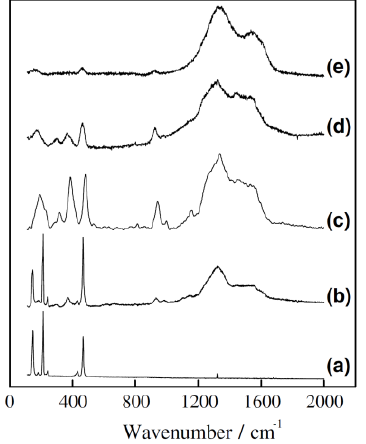
Figure 1. Raman spectra for (a) sulfur, and sulfurized polyacrylonitrile (SPAN) made by heating a 4:1 (wt) S/PAN mixture for 8 h at temperature of (b) 250 °C; (c) 300 °C; (d) 450 °C; and (e) 800 °C. Reproduced with permission of Elsevier from